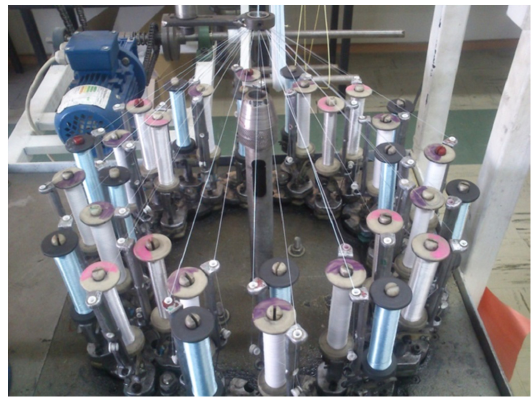
Figure 1. 32-carrier vertical braiding machine used for manufacturing of sutures.